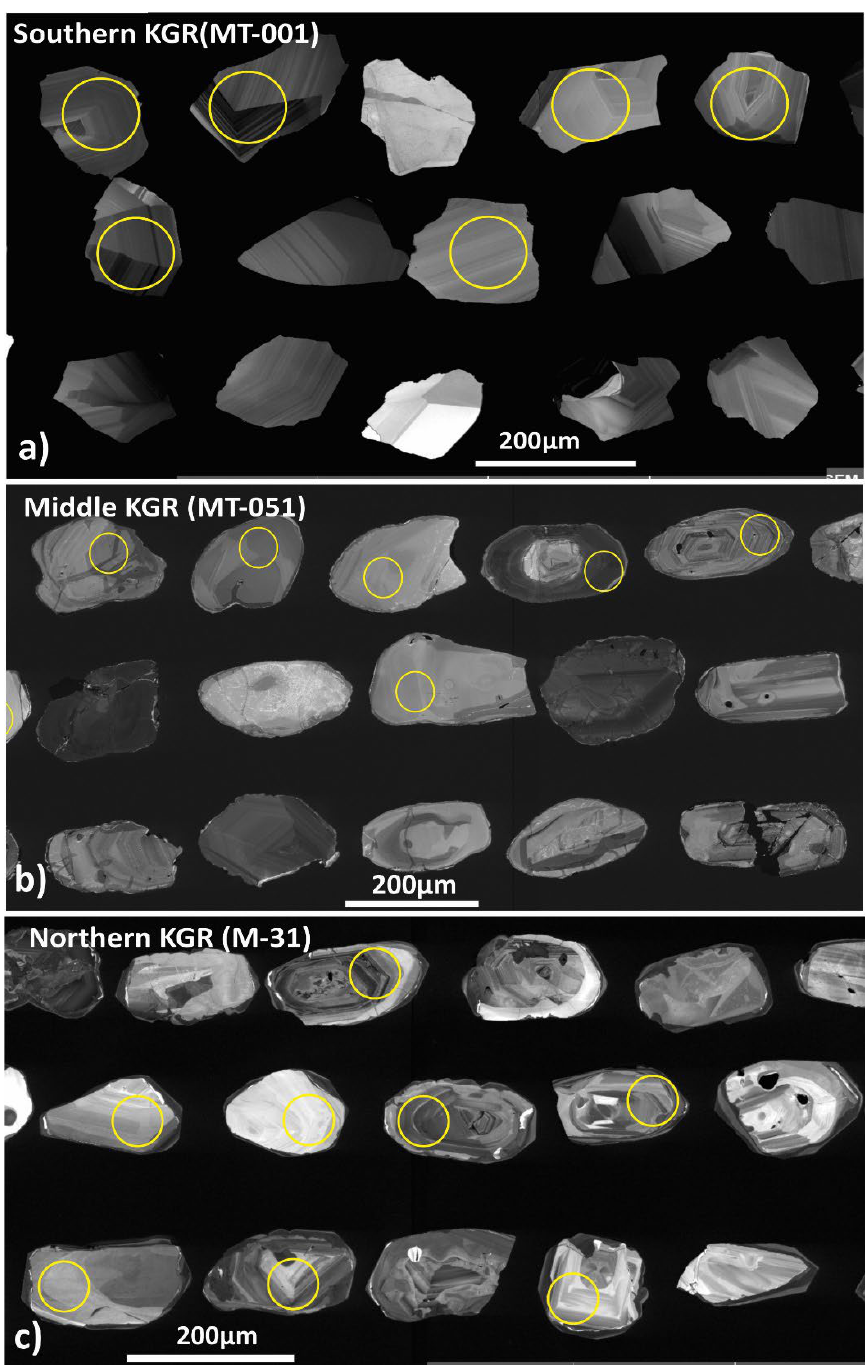
Figure 4. Representative CL image of three regions of the studied area ( a ) southern, ( b ) middle and ( c ) northern KGR. The circle represents the sot location.